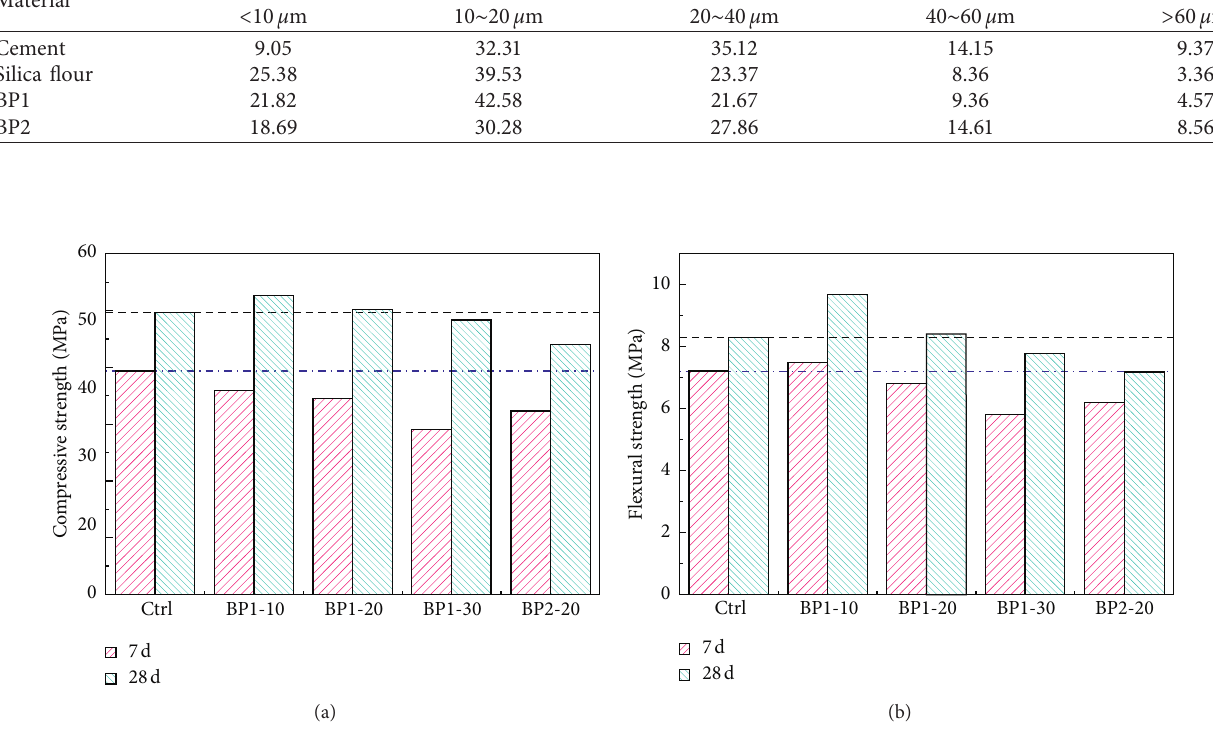
Figure 3: The effect of brick powder on the (a) compressive strength and (b) flexural strength of cement mortar.